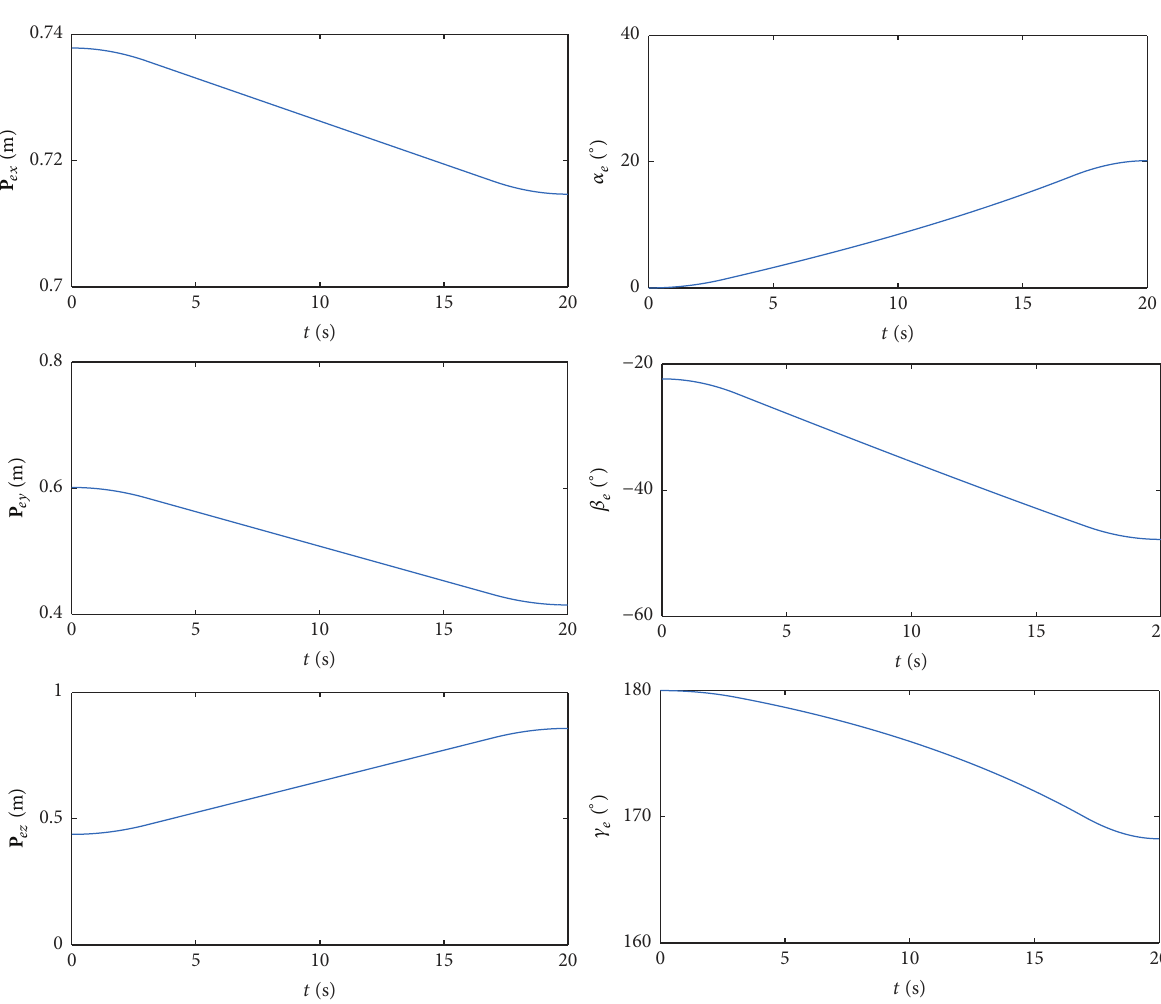
Figure 2: The desired position and attitude tracking path of the end-effector.